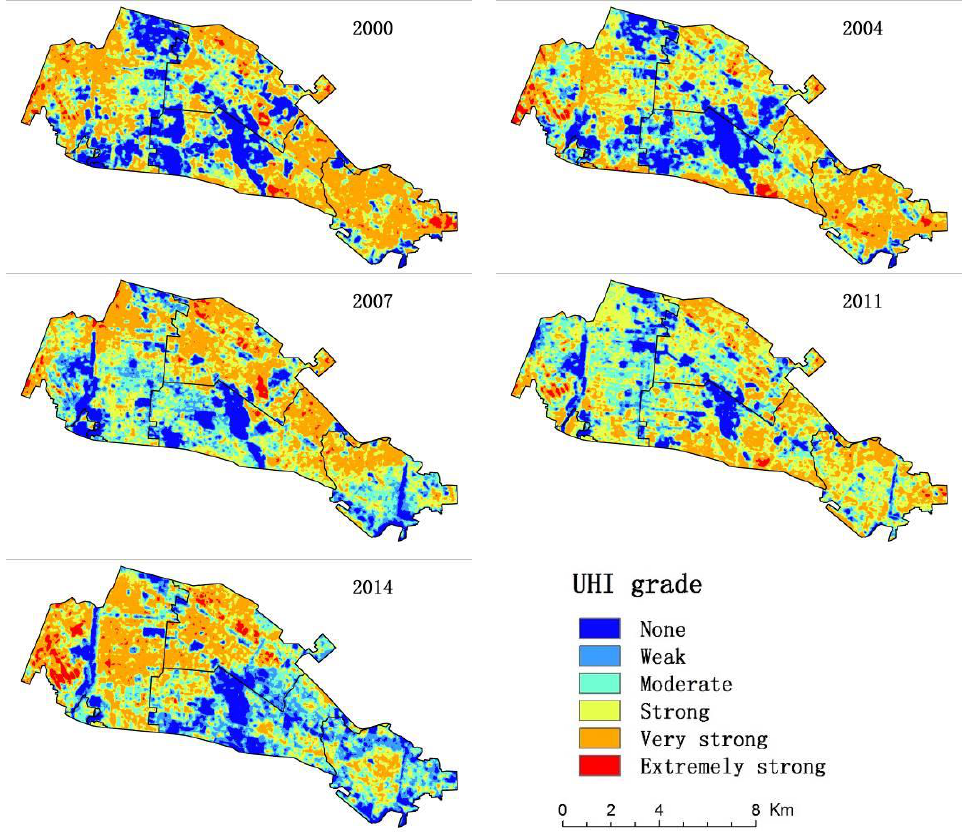
Figure 2. Intensity map of heat islands in Baotou. The UHI intensity was classified into six categories, with the colors from blue to red representing the intensity of UHIs from weak to strong.